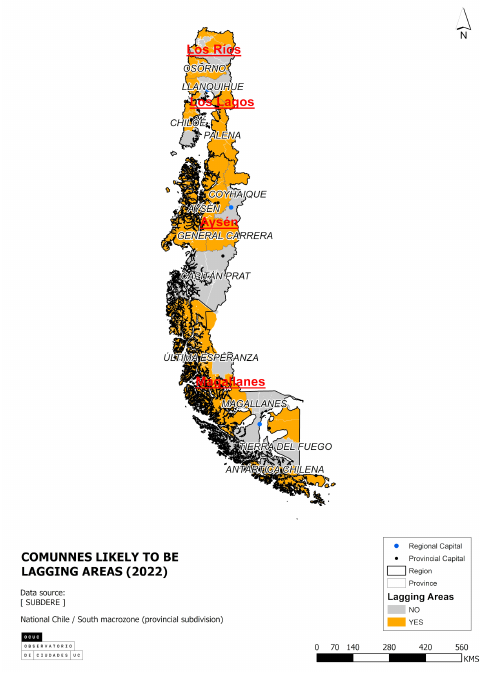
Figure 9: Lag zones by district and province of the southern central macrozone of